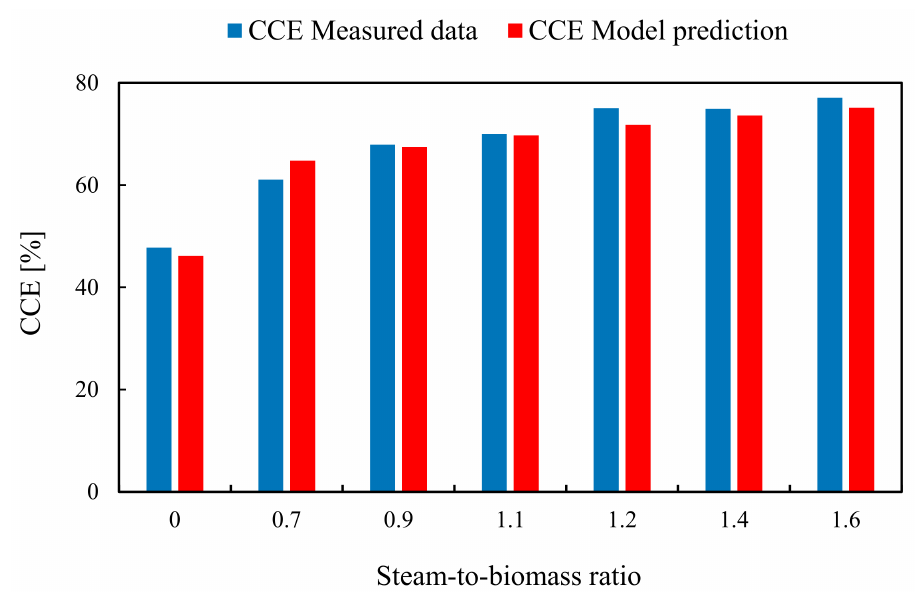
Figure 12. Effect of SBR on carbon conversion